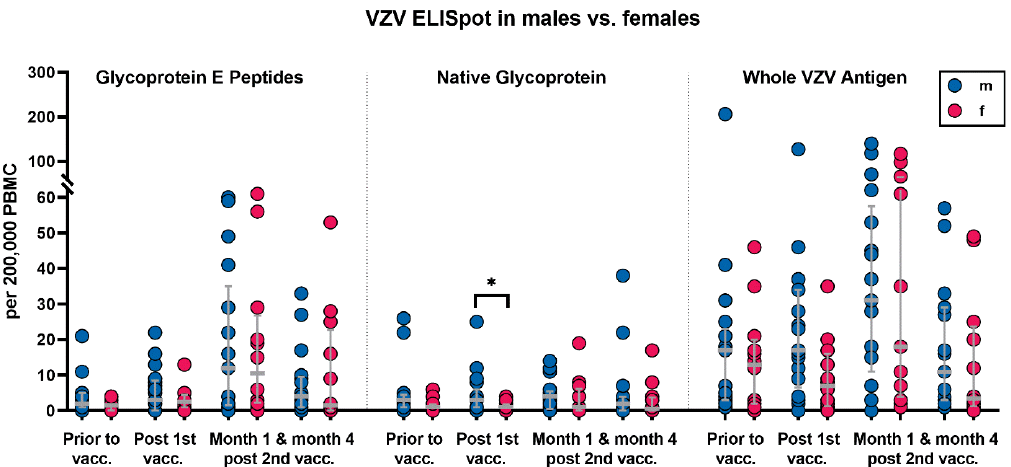
Figure 3. Varicella – zoster-virus-specific ELISpot responses in 17 male and twelve female kidney transplant recipients prior to and after the first and second vaccination with Shingrix™. Blue dots indicate males and red dots indicate females. VZV-specific spots were determined as stimulated minus non-stimulated (background) values (spot increment). Gray horizontal lines represent median values and the interquartile range. Data were compared by using a Mann – Whitney test (* p < 0.05).